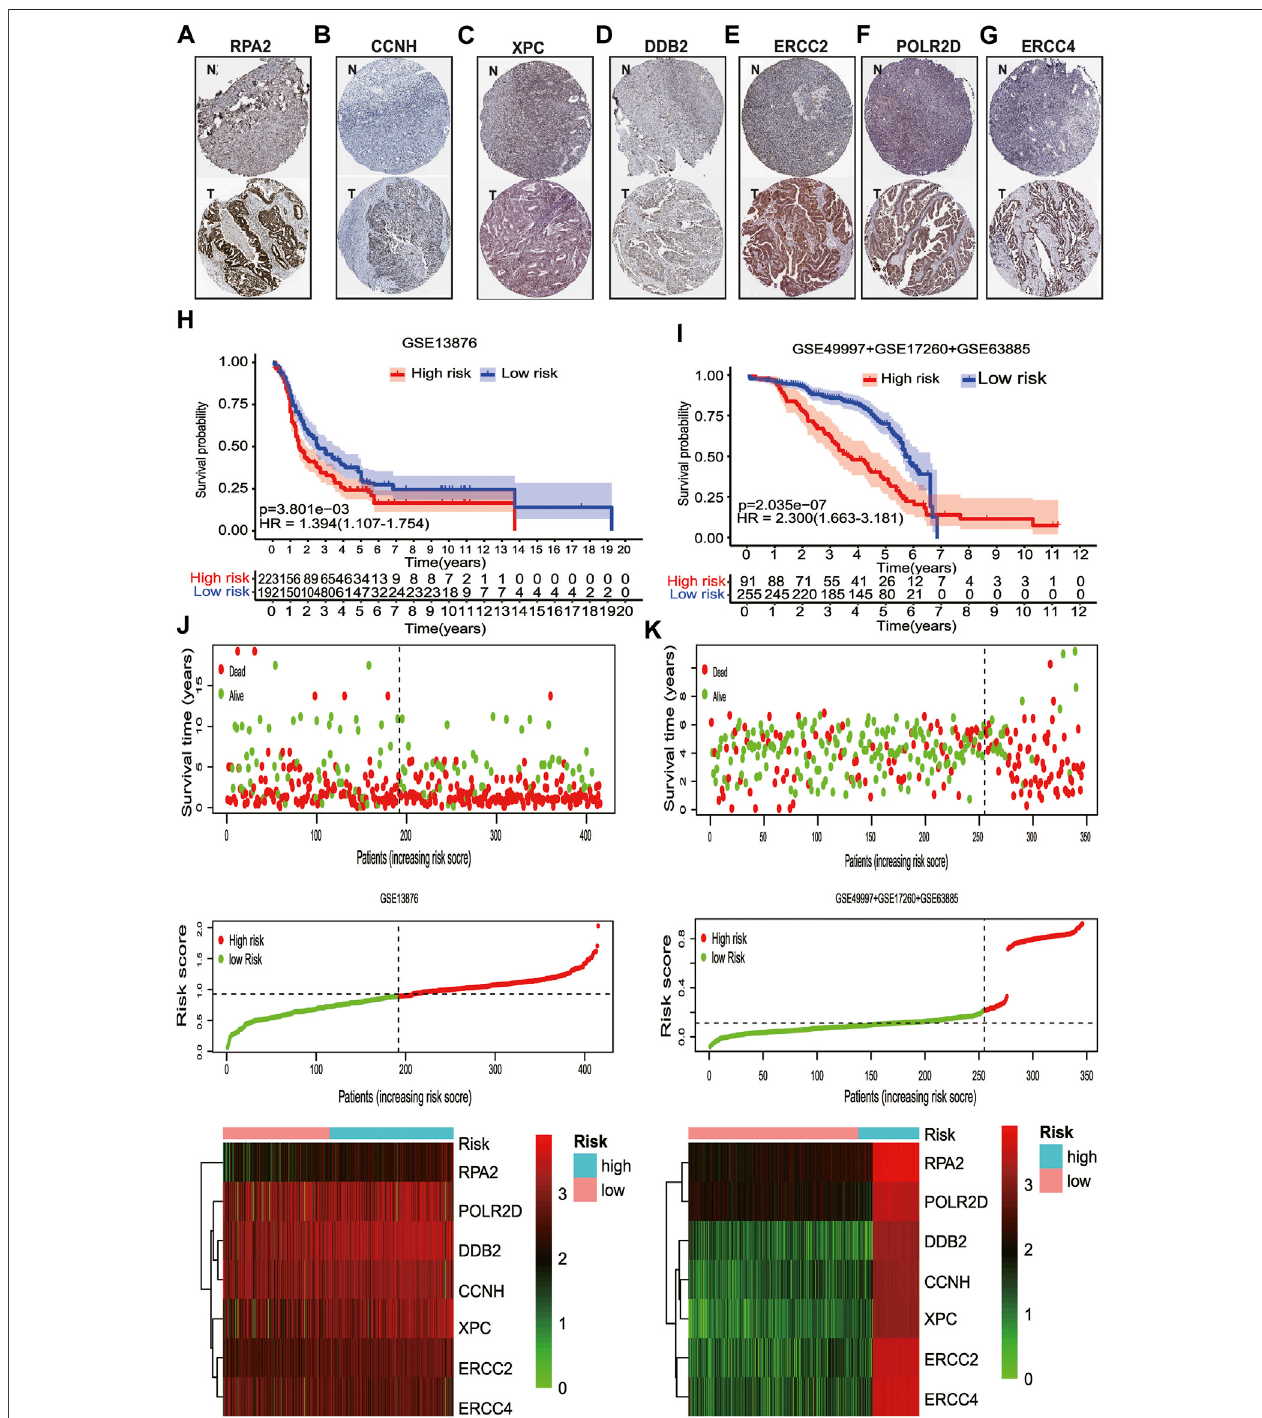
FIGURE 5 | The protein expression levels of seven NER-related genes by IHC staining and the validation of the prognostic signature. (A) Representative IHC stainingofRPA2inserousovariancancerand normalovariantissues. (B) RepresentativeIHC stainingofCCNHinserousovariancancerandnormalovariantissues. (C) Representative IHC staining of XPC in serous ovarian cancer and normal ovarian tissues. (D) Representative IHC staining of DDB2 in serous ovarian cancer and normal ovarian tissues. (E) Representative IHC staining of ERCC2 in serous ovarian cancer and normal ovarian tissues. (F) Representative IHC staining of POLR2D in serous ovarian cancer and normal ovarian tissues. (G) Representative IHC staining of ERCC4 in serous ovarian cancer and normal ovarian tissues. (H) For advanced patientswithHGSOC,thehigh-riskgrouphadasigni fi cantlyworseOSthanthatinthelow-riskgroupinGSE13876. (I) ForadvancedpatientswithHGSOC,thehigh-risk